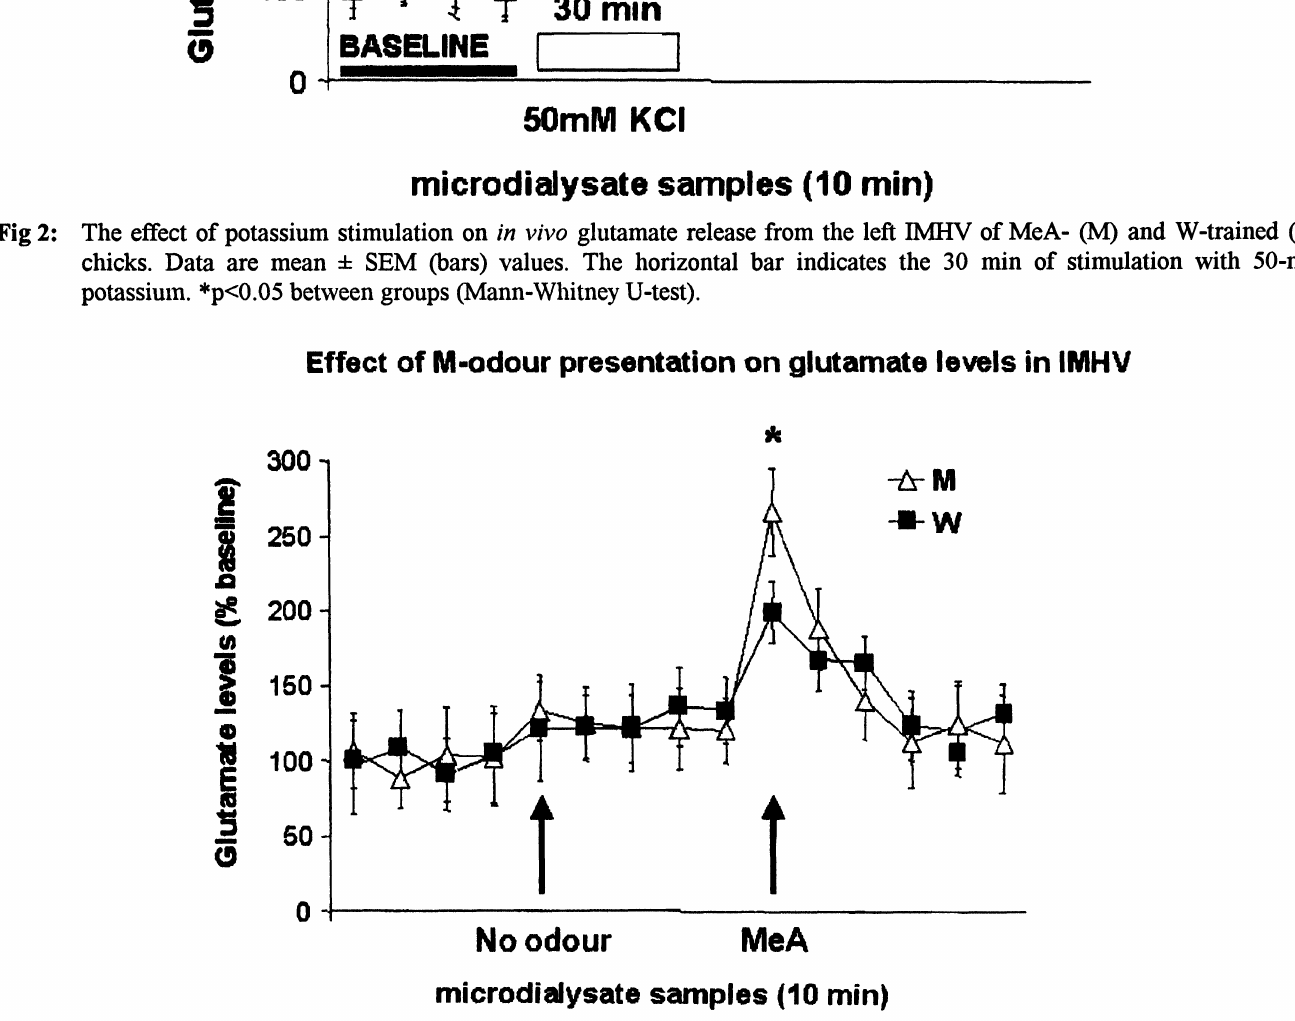
Fig 3: The effect of MeA presentation as an odor to anaesthetized MeA- (M) and W-trained (W) chicks on in vivo glutamate levels in the left IMHV. Data are mean +/- SEM (bars) values. The arrows indicate the microdialysate samples, including the times of dry tissue or MeA-soaked tissue presentation. *p <0.05 between groups (Mann-Whitney